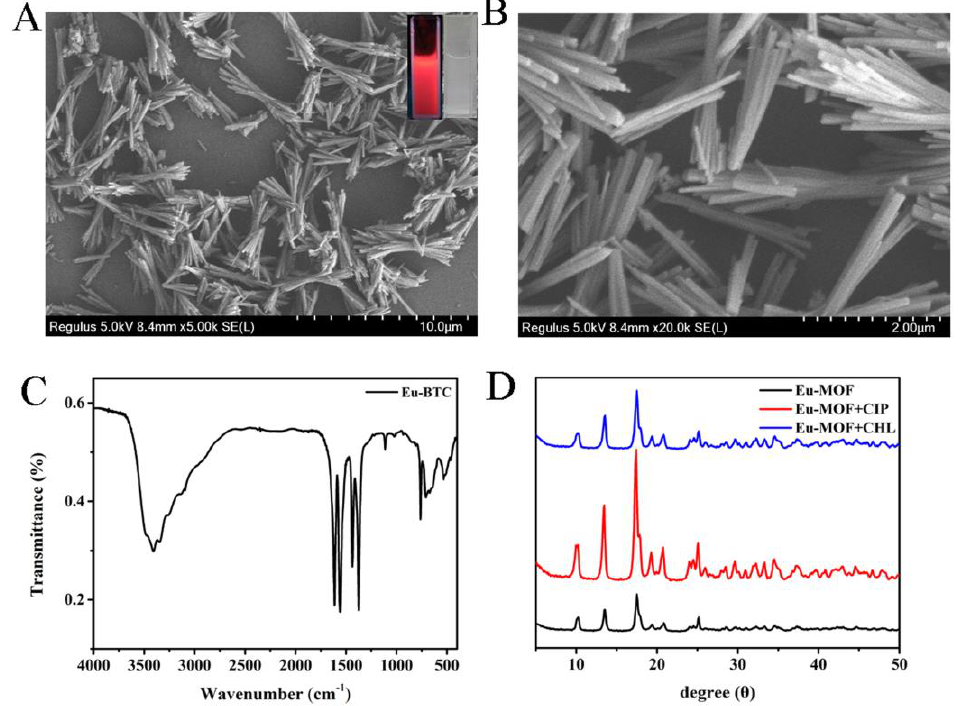
Figure 1. SEM images of Eu-MOF at low magnification ( A ) and high magnification ( B ); ( C ) FTIR spectra of Eu-MOF; ( D ) XRD spectra of Eu-MOF before and after the addition of CIP and CHL; Inset of ( A ): optical images of Eu-MOF solution under a UV lamp (left) and natural light (right);